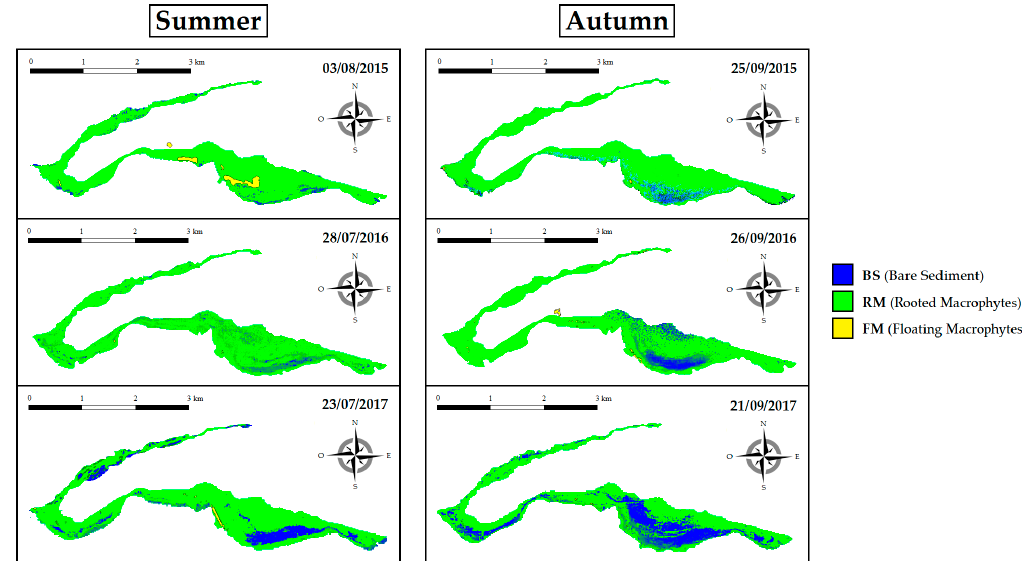
Figure 6. Spatial coverage of BS (blue), RM (light green), and FM (yellow) in summer ( left panels ) and in autumn ( right panels ).